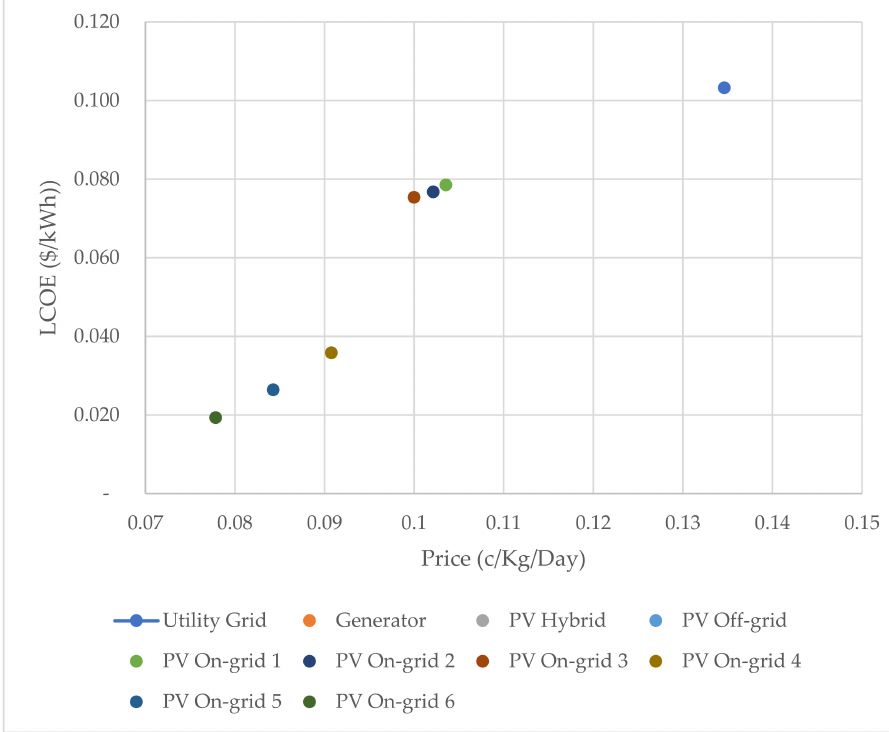
Figure 12. LCOE and Rent Price of Cold Storage for Community-based